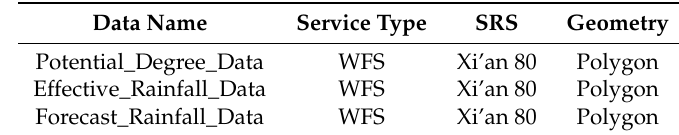
Table 2. Data access services involved in EWATask.